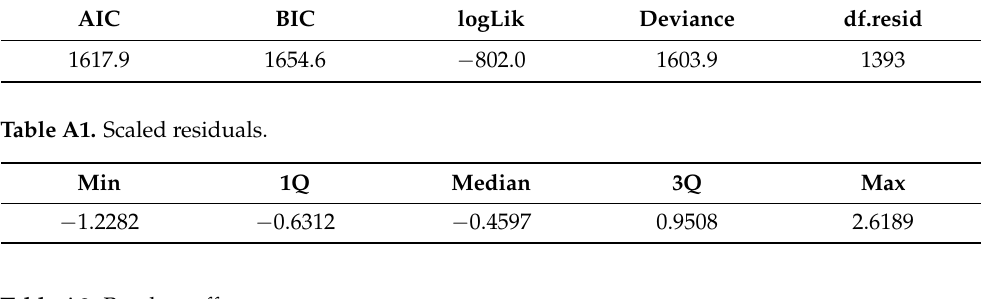
Table A2. Random effects.